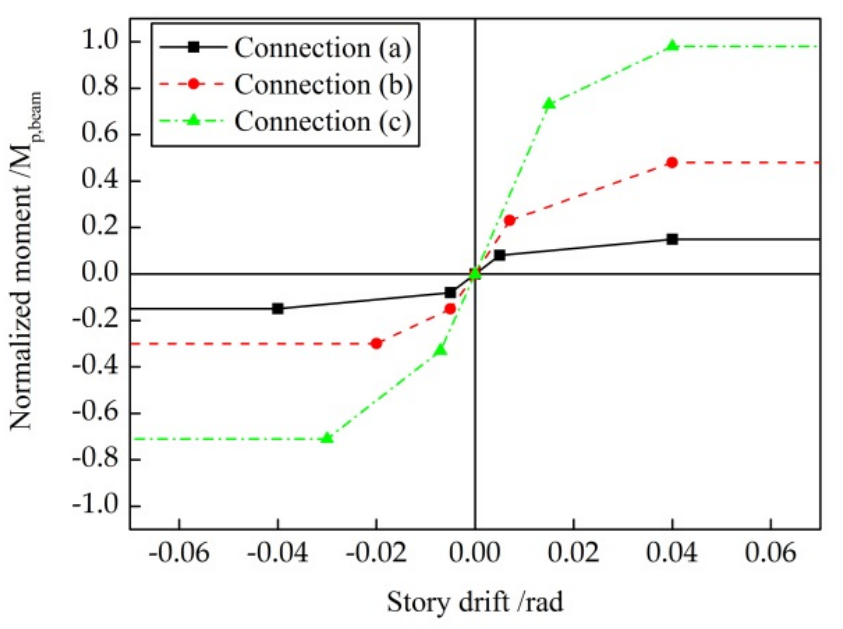
Figure 4. Connection models in S1 and S2.